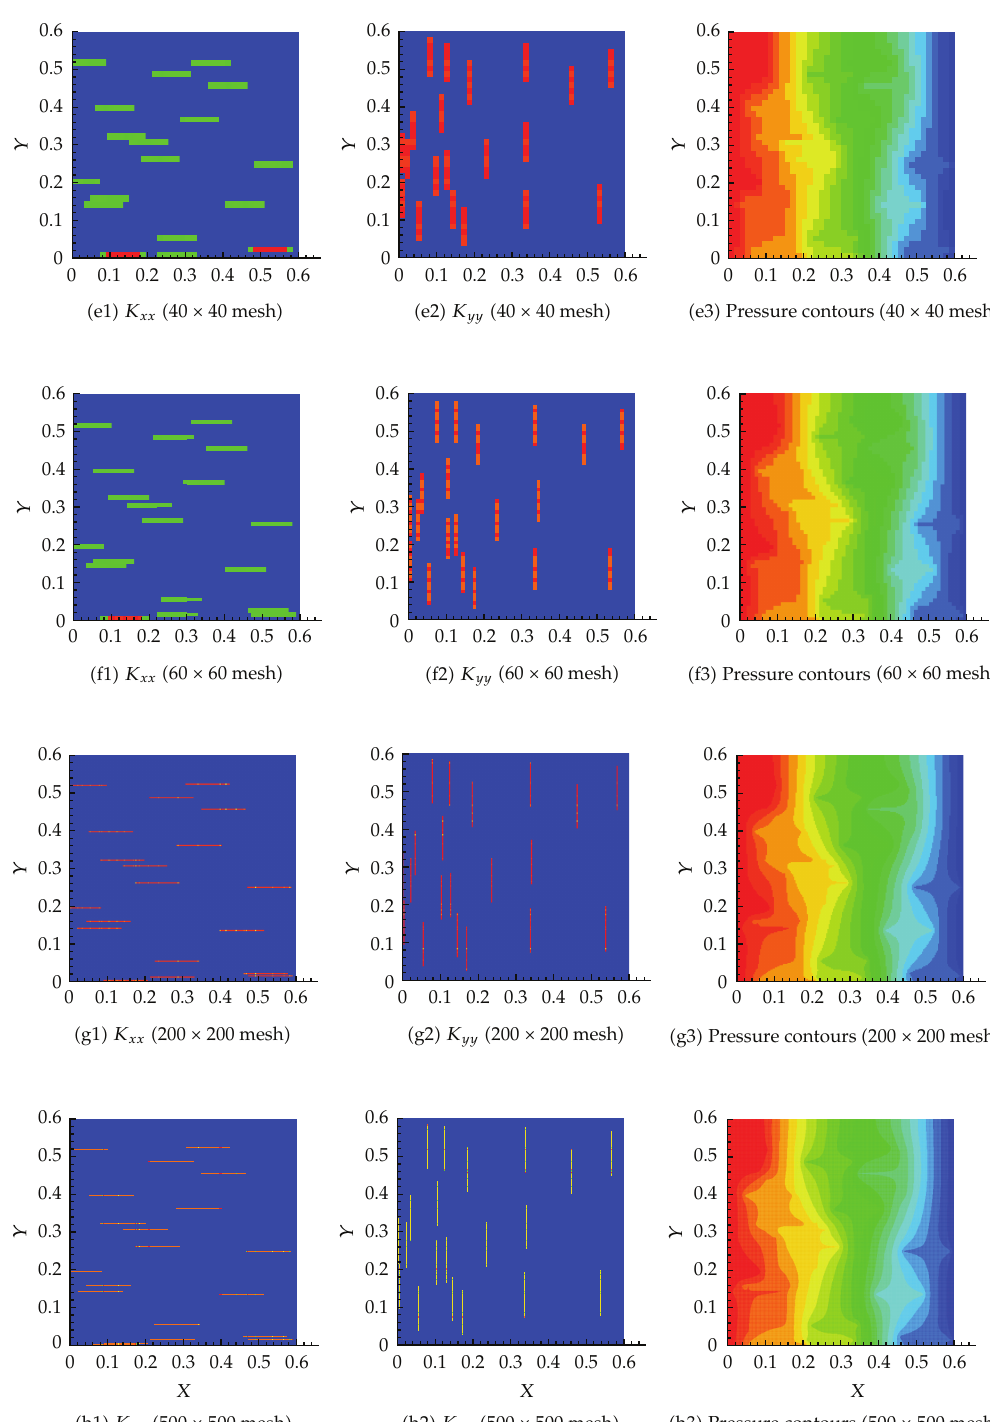
Figure 10: E ff ective permeability and pressure contours for the 40 fractures scenarios for di ff erent degrees of